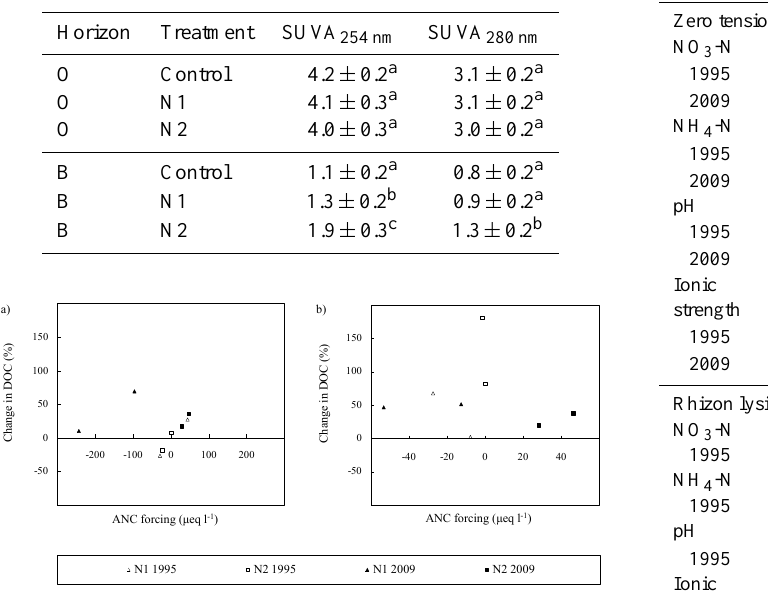
Fig. 4. Change in dissolved organic carbon, DOC, by treatments N1 and N2 (change in % of annual mean of Control) in O horizon ZTLs (a) and mineral B horizon TLs (b) and acid neutralizing capacity (ANC) forcing in mueqL − 1 (Evans et al., 2008) at Str˚asan.